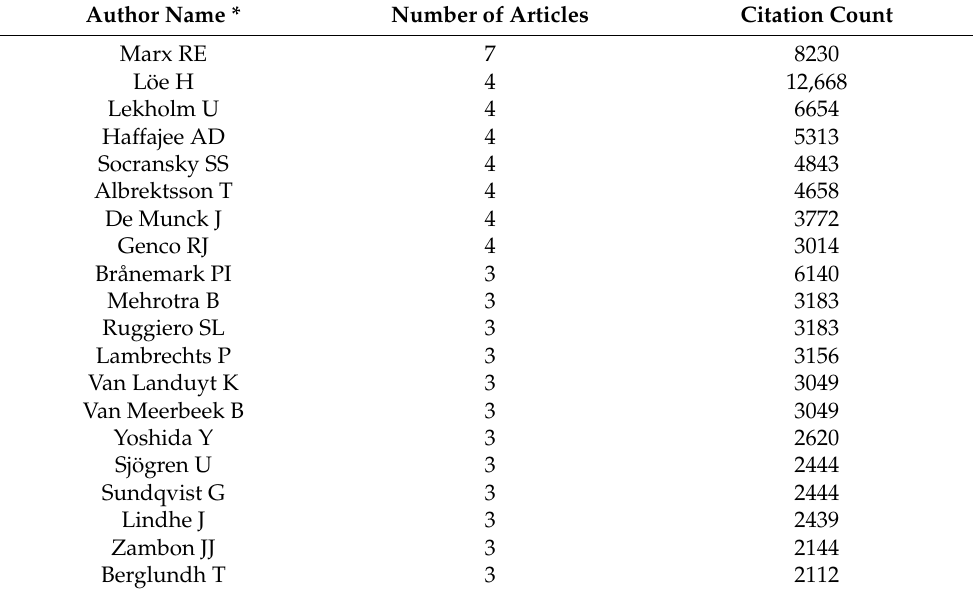
Table 1. Contribution of authors to the top 100 most-cited articles in